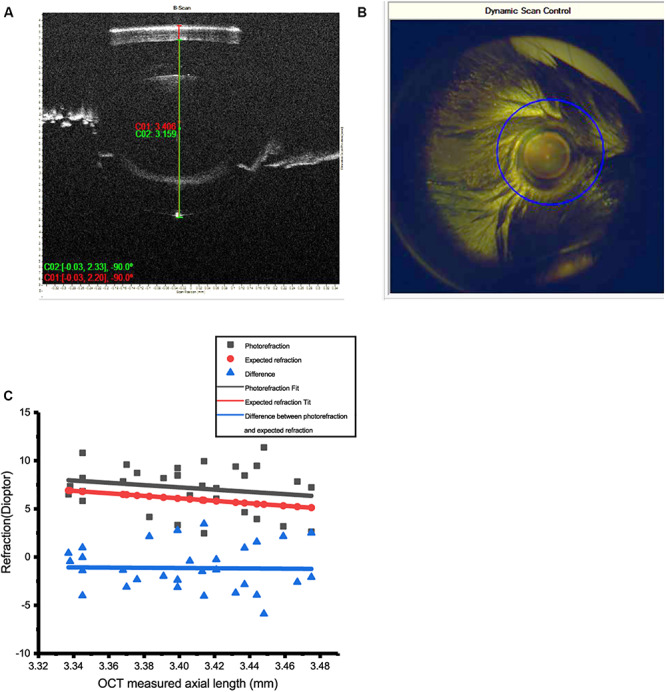
Measurement of refractive errors (RE) in mice by photorefraction and OCT. (A) Axial length (AL) of the mouse eye was measured from the surface of the cornea to the RPE layer by OCT. (B) The optical axis of the mouse eye can be precisely aligned with dynamic scan control of OCT. (C) AL measured by OCT could be used to predict RE in 8-week-old WT mice. Refractive errors of 30 eyes of WT mice (photorefraction) fitted by linear regression (red line, R2 = 0.042) matched the data of AL estimated from OCT (black line, R2 = 0.99). The difference between these two methods is close to 0 (blue line, R2 = 0.1%). Calculation: RE = 38 – 1.544/(1.03 × AL).